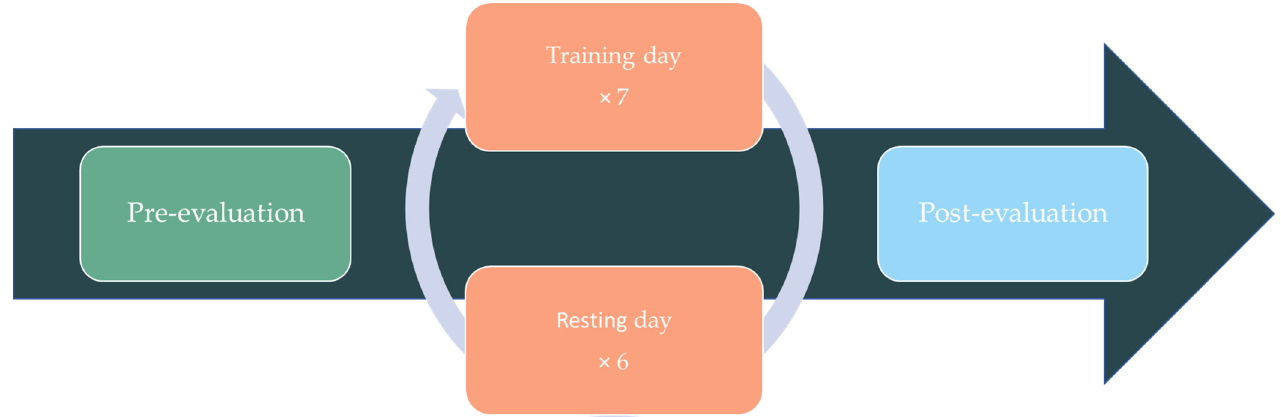
Figure 3. Timeline representation of Phase II.